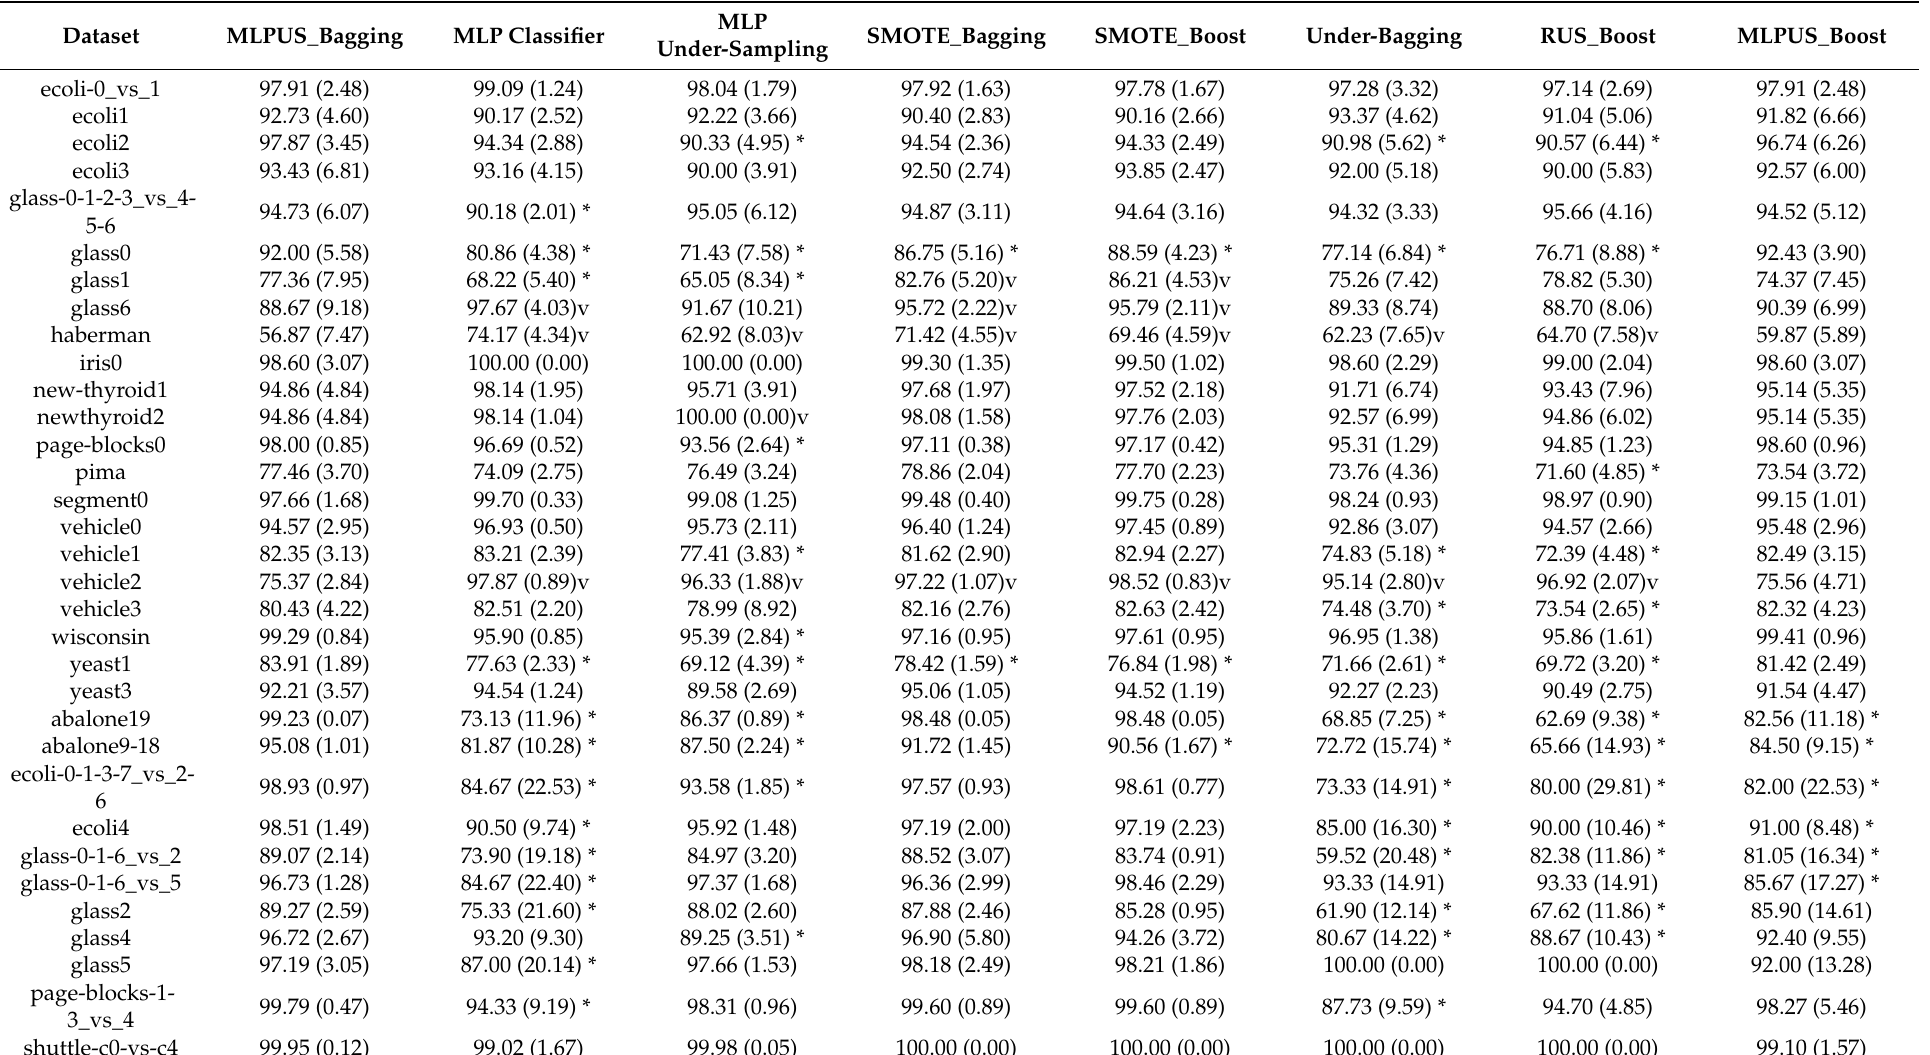
Table 4. Accuracy results of all methods for all